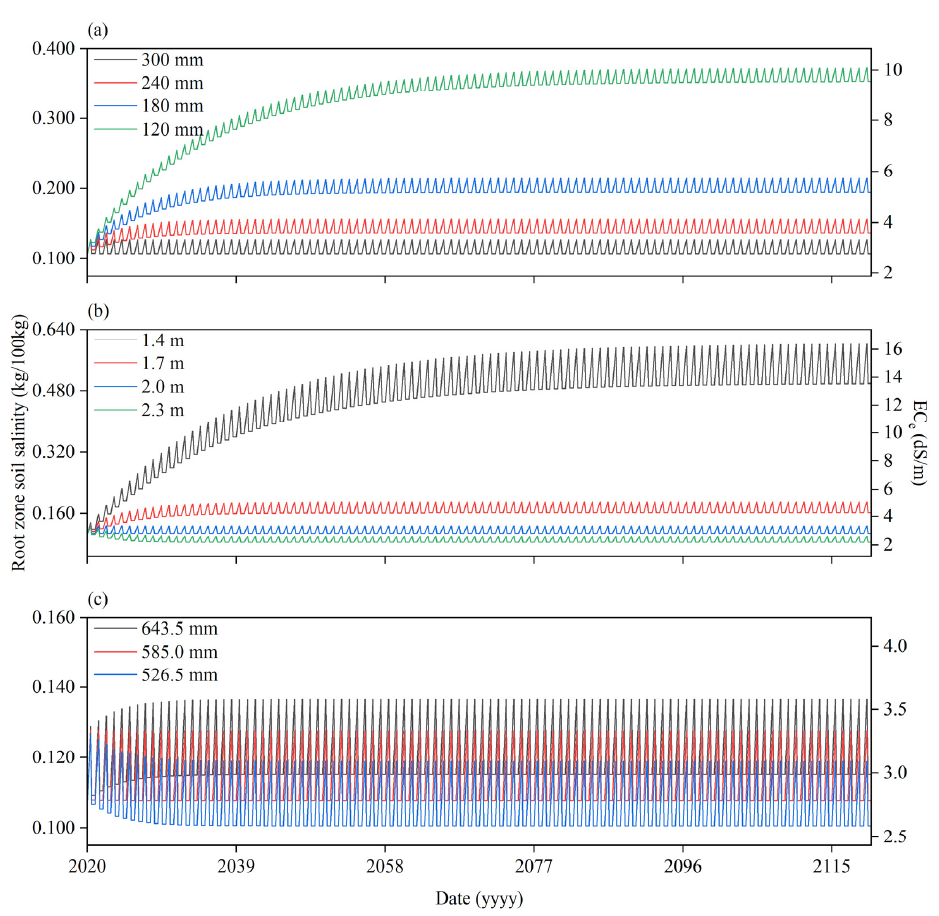
Figure 10. Root zone soil salinity variation in the canal-irrigated area under different ( a ) autumn irrigation, ( b ) water table depth, ( c ) irrigation in the crop growing period.